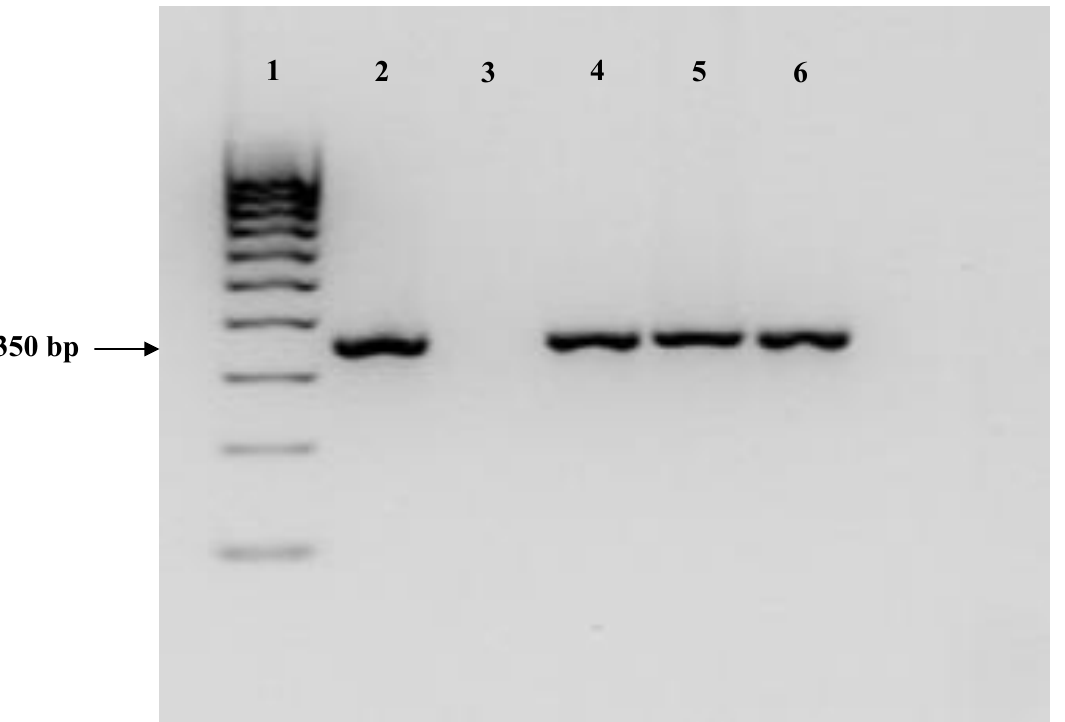
Figure 1. PCR assay for the detection of the bacteriocin Abp118 structural gene. Lane 1: marker (Hyperladder TM 100 bp, BIOLINE, London, UK). Lane 2: positive control. Lane 3: negative control. Lanes 4, 5 and 6: L. salivarius PS7. Table 1. Antimicrobial activity of L. salivarius PS7 against bacterial strains isolated from clinical cases of AOM, as assessed by different assays.